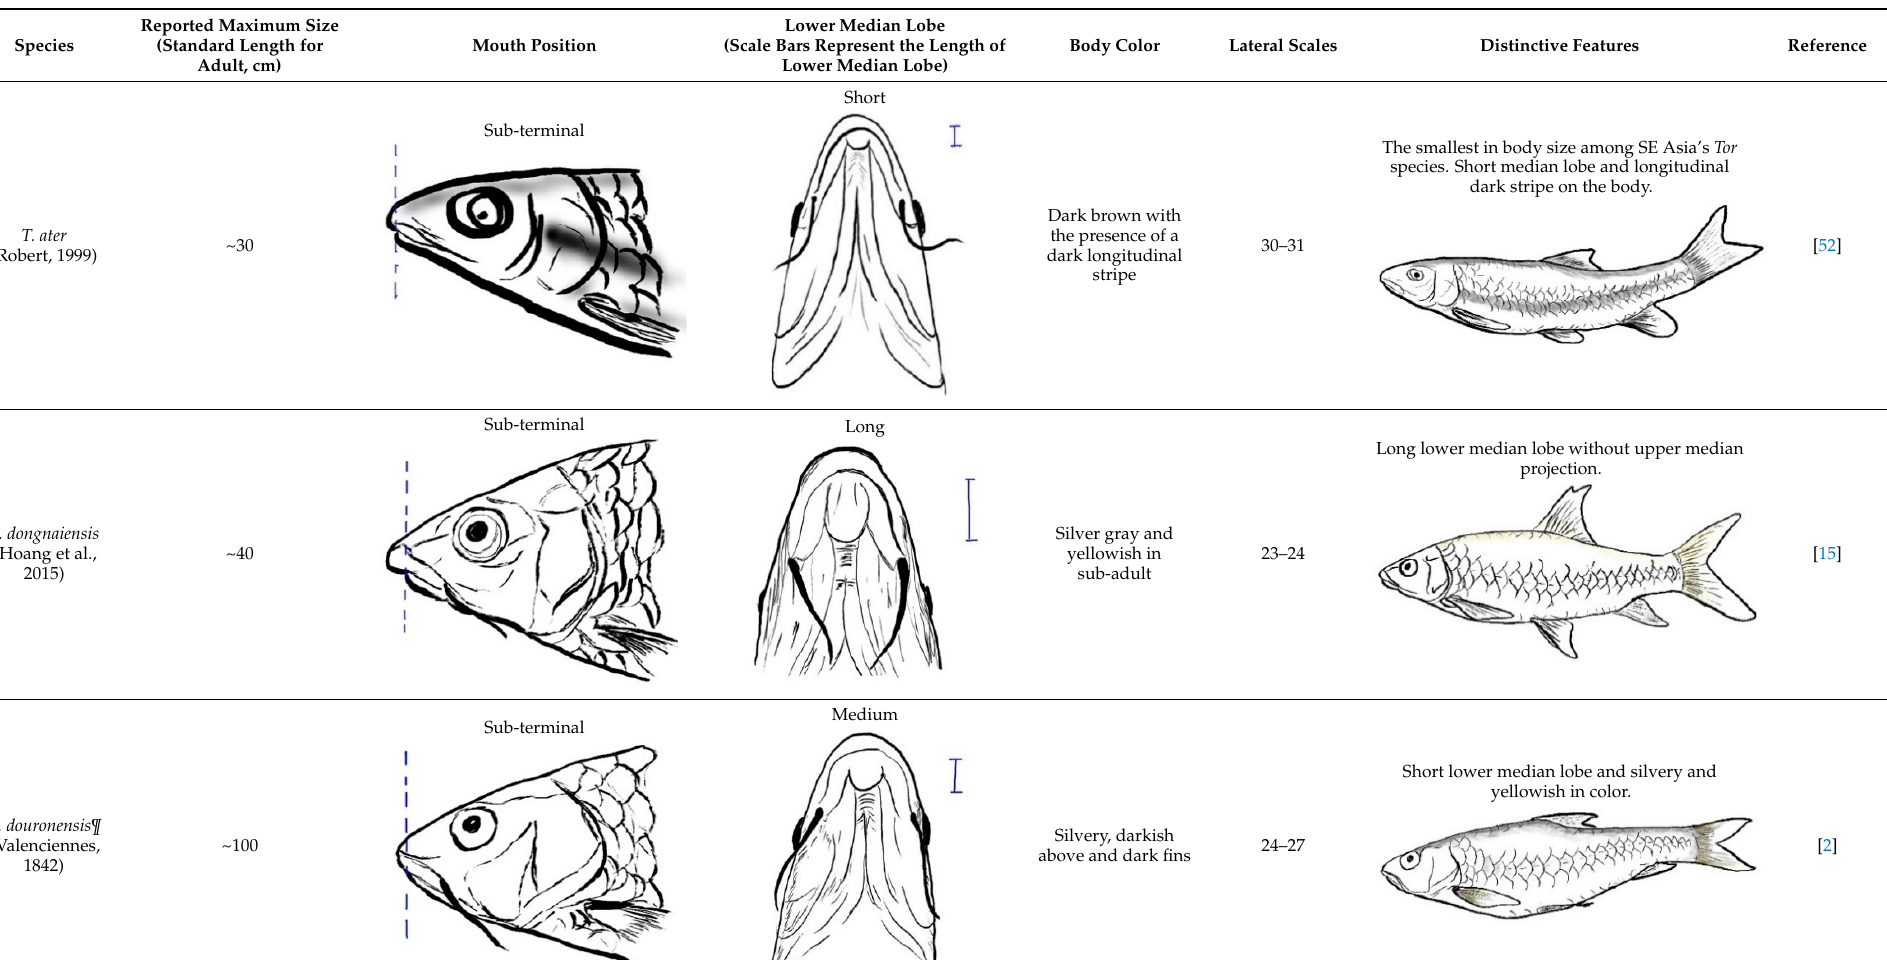
The smallest in body size among SE Asia’s Tor species. Short median lobe and longitudinal dark stripe on the body.